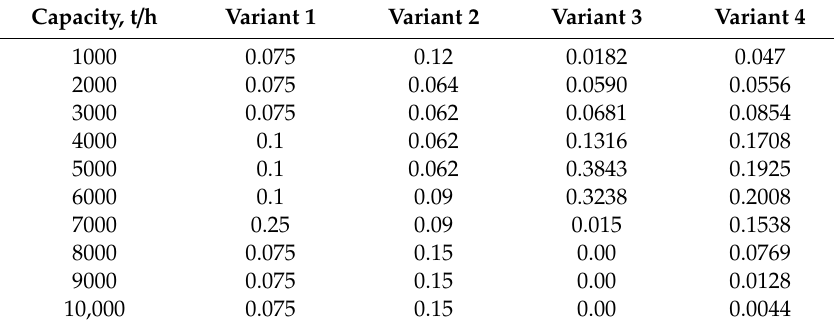
Table 3. Distribution of actual conveyor